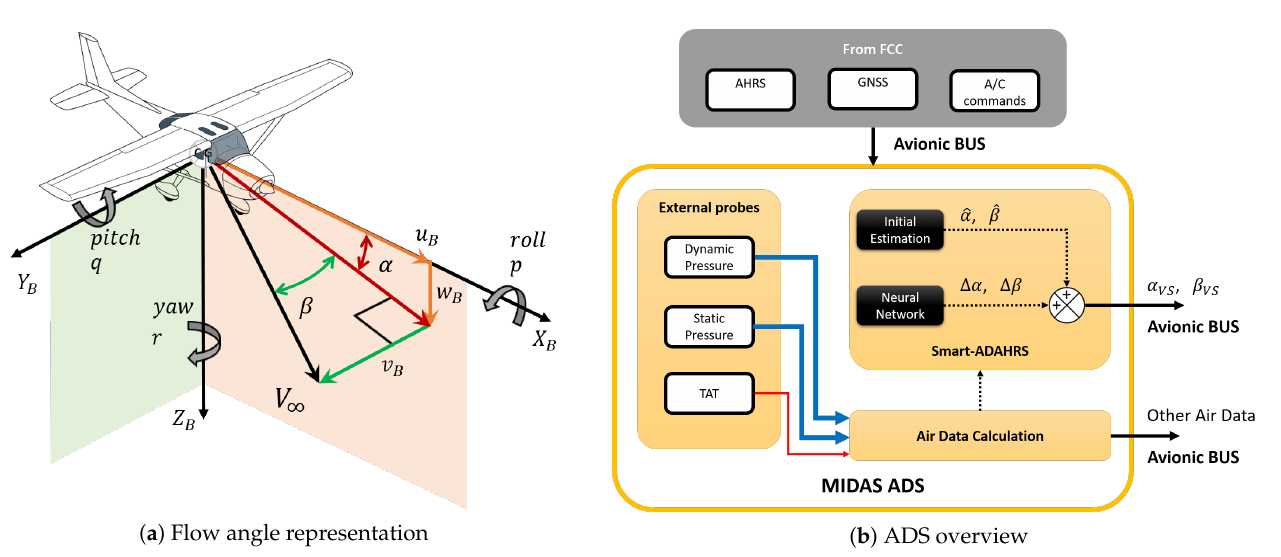
Figure 3. Aircraft model and ADS